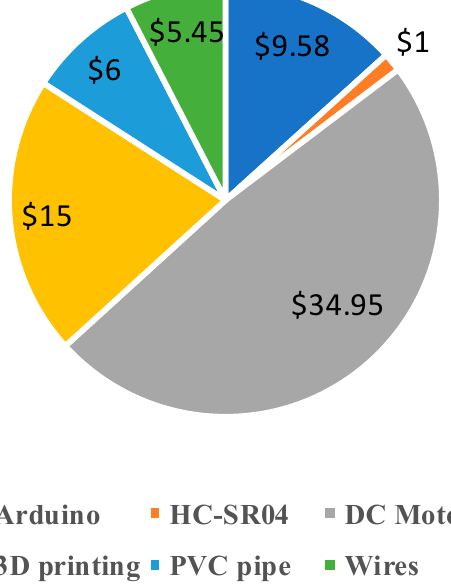
Figure 2. Prototype cost breakdown by component.